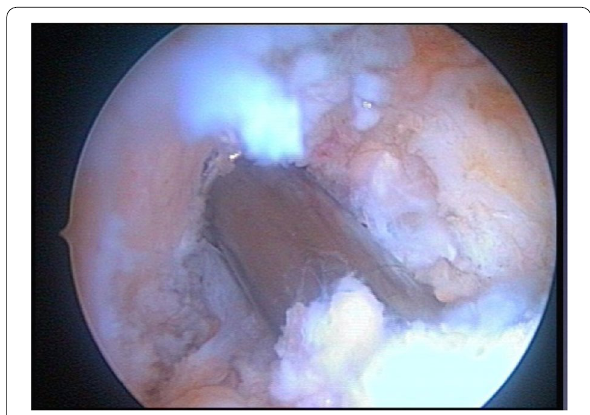
Fig. 3 Femoral tunnel made with TT technique, arthroscopic